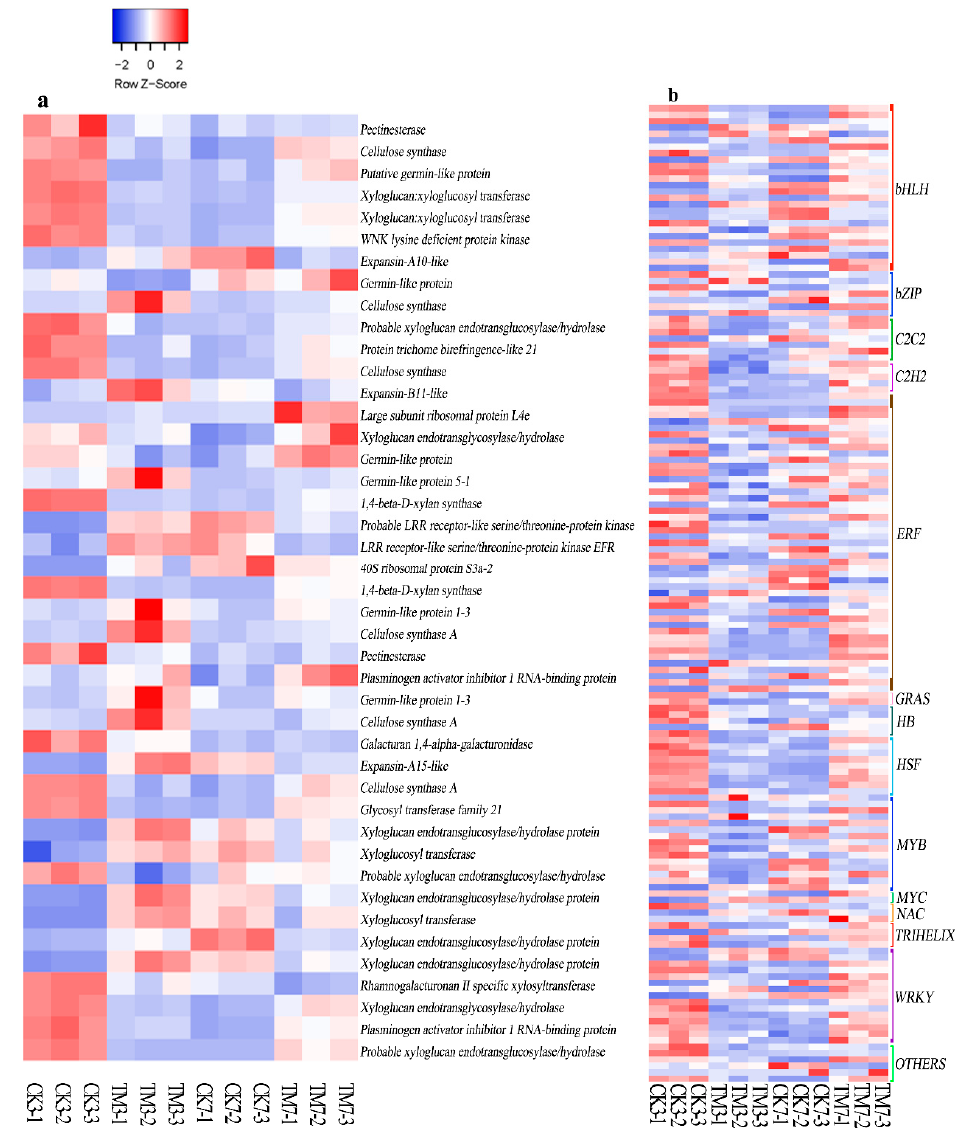
Figure 5. Heat map of DEGs related to cell wall modification, and transcription factors. ( a ) Cell wall modification-related genes, ( b ) transcription factors. The color key represents log2-transformed fold changes: red indicates high expression, while blue represents low expression. Heat map representing transcripts per million (TPM) expression from RNA-seq. The Z-score scale is shown in the top-left corner, and it ranges from red to blue.